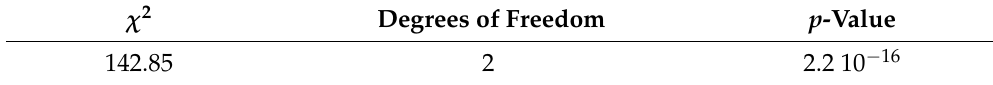
Table A3. Results of the Kruskal–Wallis test on the NO x showing that significant differences exist.